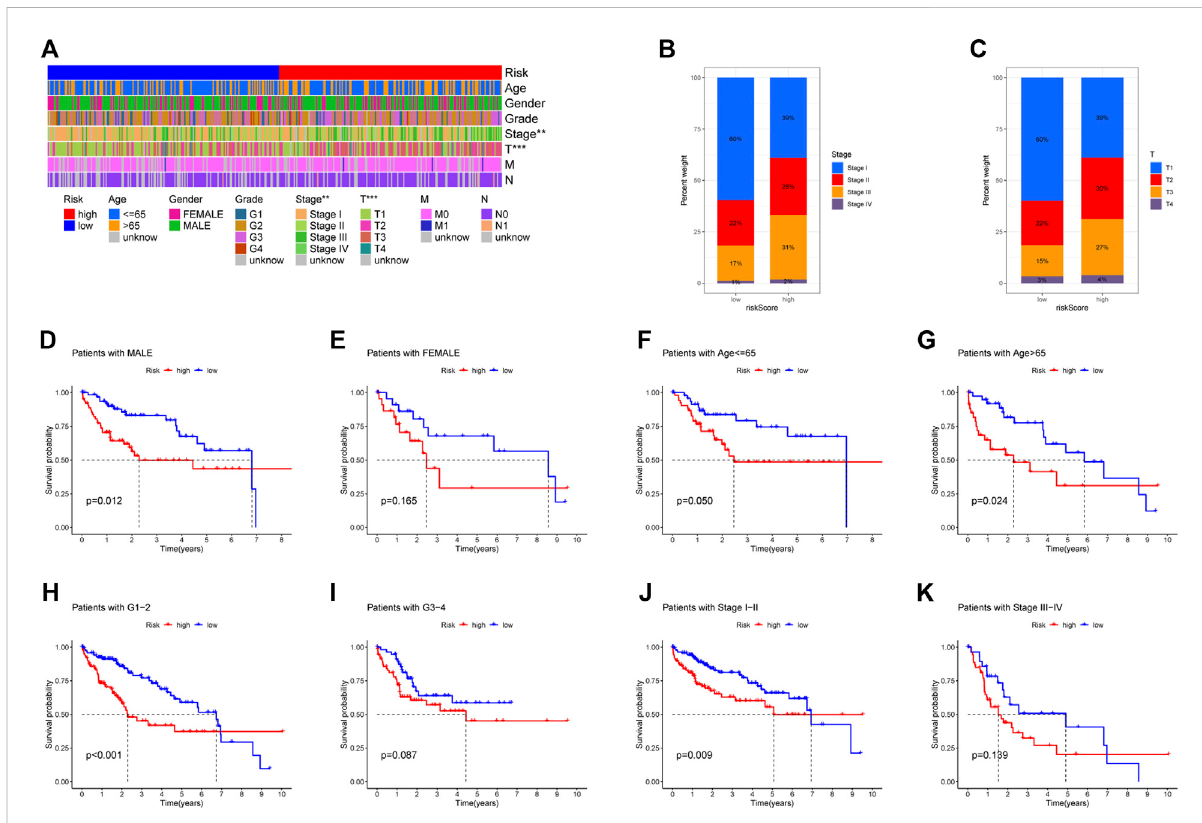
FIGURE 5 Comparison of overall survival (OS) between subgroups of individuals with different clinicopathological features. (A) The risk-clinical characteristic heatmap was used to visualize this relationship ( p p < 0:05, pp p < 0:01, and ppp p < 0:001). (B) Distribution of AJCC stage in two groups. (C) Distribution of T-stage in two groups. (D – E) Subgroup of gender (male and female). (F – G) Subgroup of age ( ≤ 65 years and > 65 years). (H – I) Subgroup of grade (G1, G2, G3, and G4). (J – K) Subgroup of AJCC stage (I, II III, and